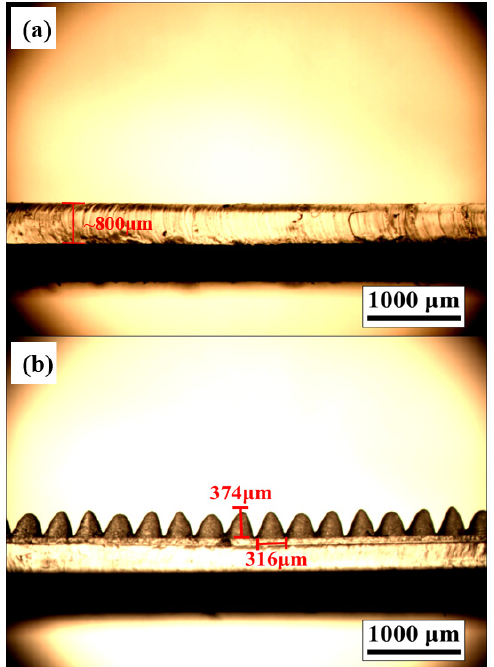
Figure 3. ( a , b ) OM diagram of smooth surface and 374 μ m microneedle structure on PDMS. Both of these two samples are ~800 μ m thick.